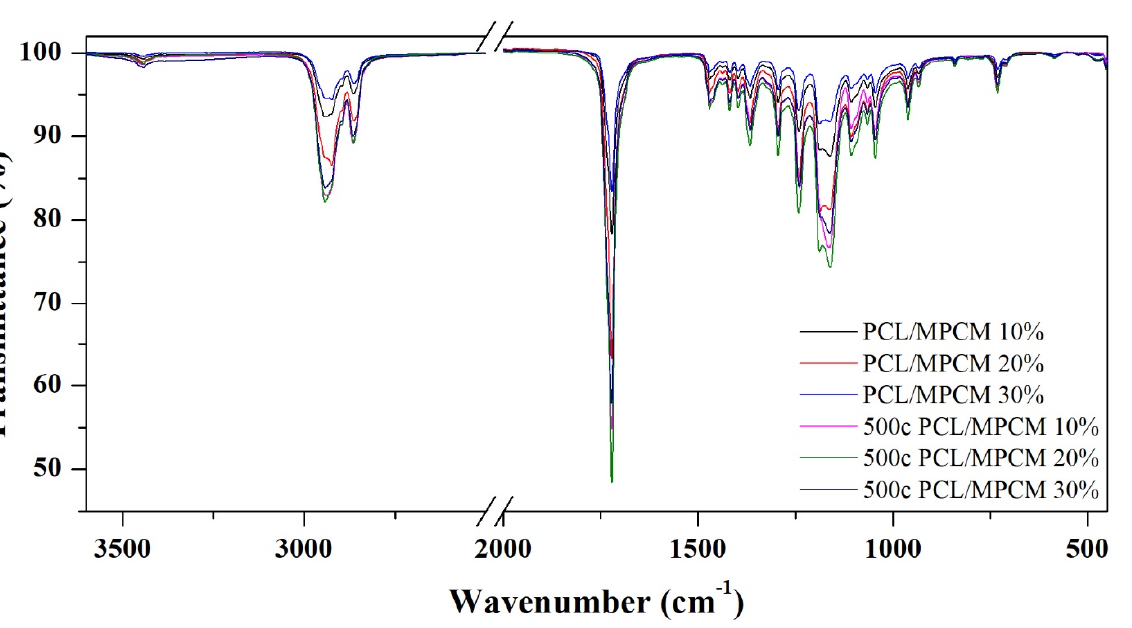
Figure 11. FT-IR spectra before and after the thermal cycling of MPCM CSS-PCM until 30 wt.%.